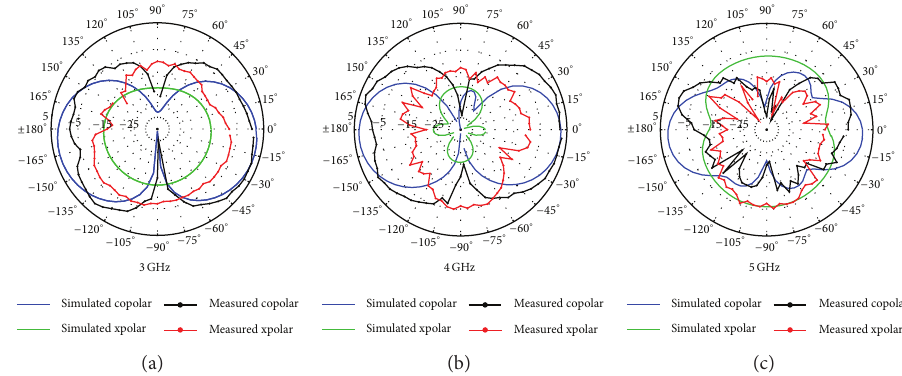
Figure 8: Simulated and measured radiation pattern in the E-plane (yoz) (10dB/div).